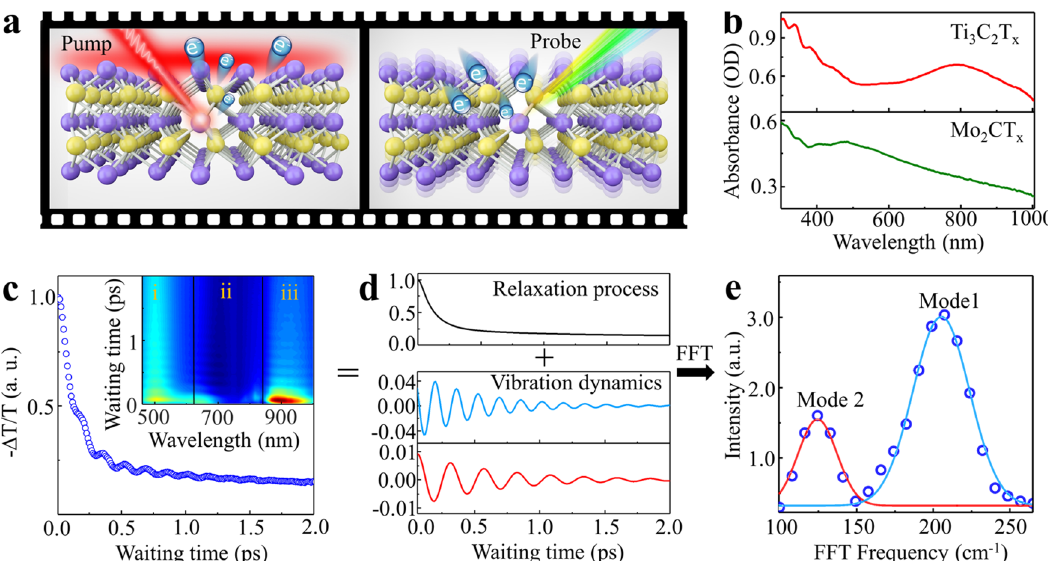
Fig. 2 | Concept of the broadband impulsive vibrational spectroscopy (IVS) experiment with plasmonic MXenes. a The scheme of the pump-probe IVS used to measure the SP-vibrational coupling and vibrations of Ti 3 C 2 T x . The pump pulse generates excited electrons, and then the dynamics of electrons and lattices were monitoredbytheprobepulse. b AbsorptionspectraofplasmonicMXenes:Ti 3 C 2 T x (red line) and Mo 2 CT x (green line) fi lms. c The pump-probe data detected at